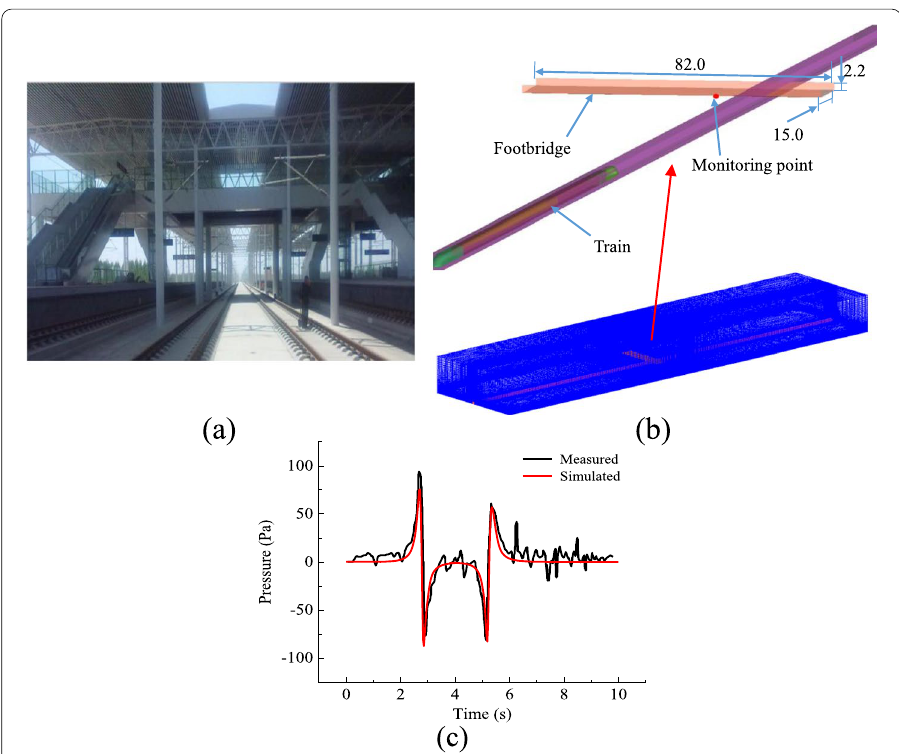
Fig. 2 Model verification of an overpass bridge: a photograph of overpass bridge (Yang et al. 2015); b model of high-speed train crossing under overpass bridge (unit: m); c comparison of simulated and measured wind